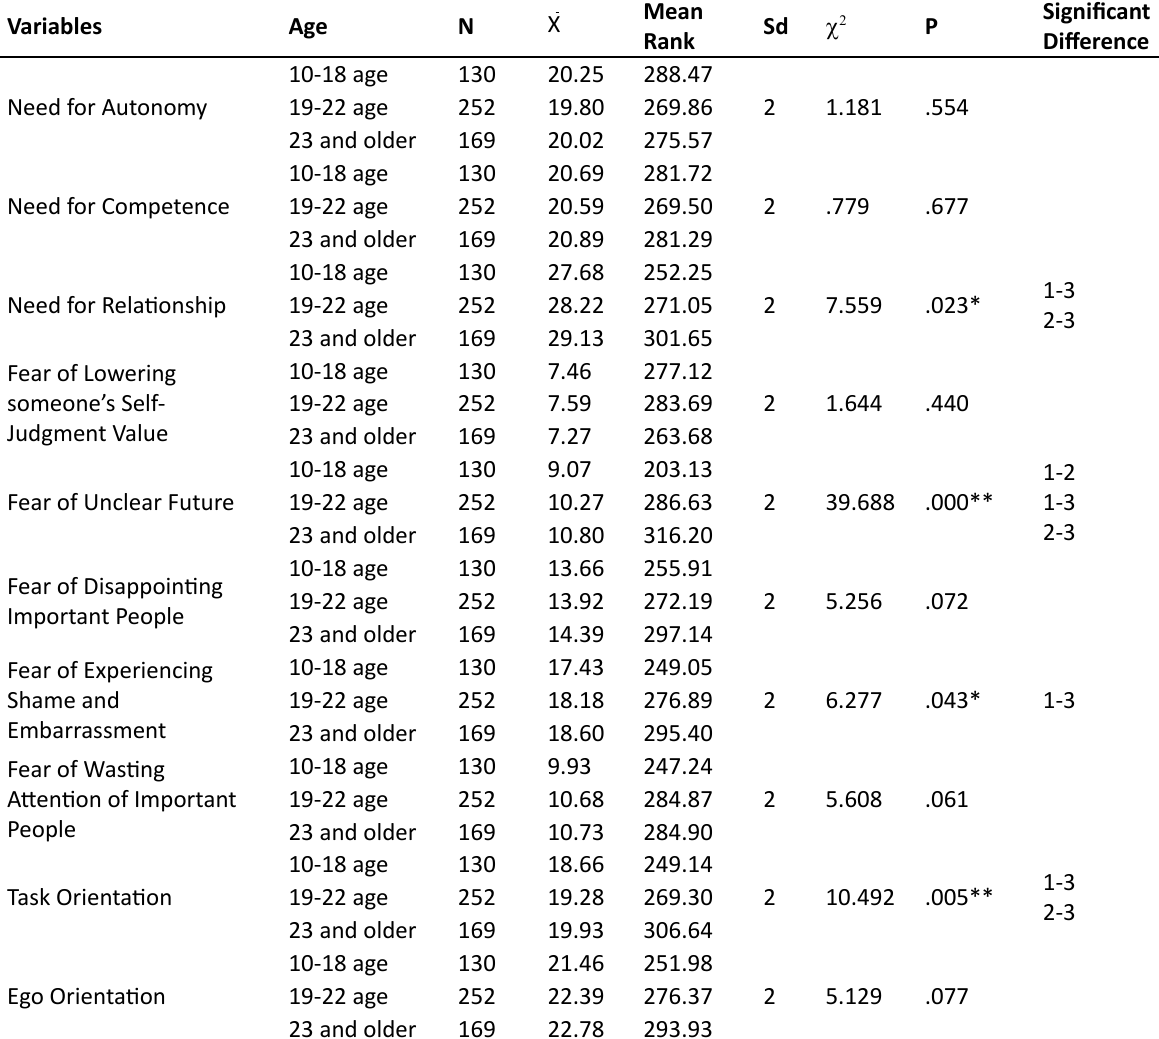
Table 2. Evaluation of the grades of the participants’ basic psychological needs, performance failure appraisal and task and ego orientation in sport according to age variable Variables